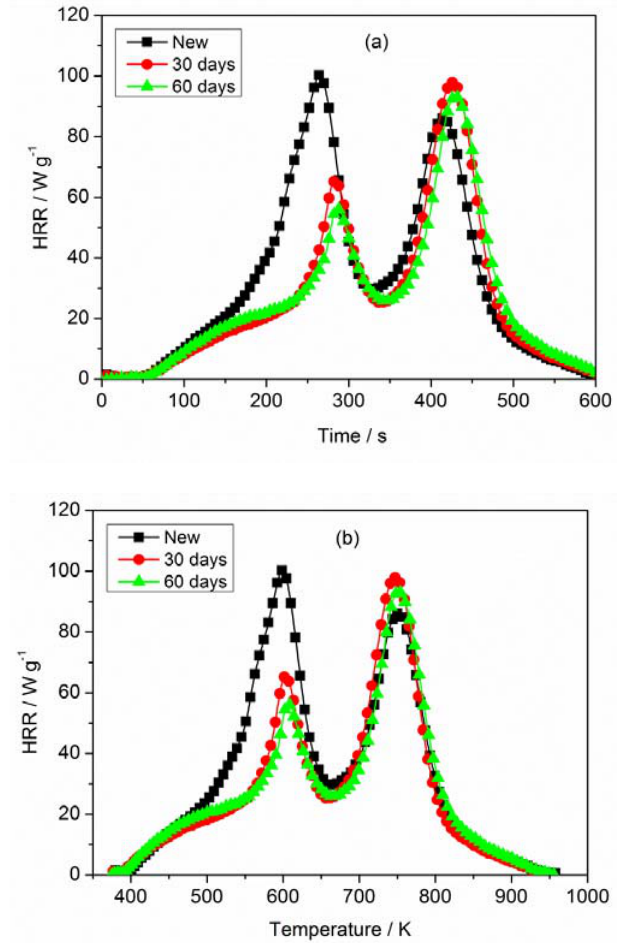
Figure 7. Heat release rate of PVC sheaths for new and aged cables: ( a ) heat release rate (HRR) vs. time and ( b ) HRR vs. temperature.